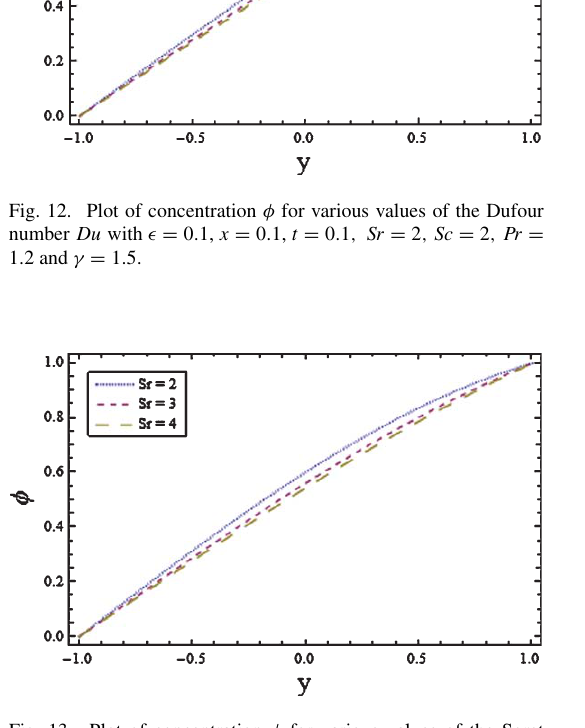
Fig. 13. Plot of concentration φ for various values of the Soret number Sr with (cid:15) = 0 . 1, x = 0 . 1, t = 0 . 1 , Du = 2 , Sc = 2 , Pr = 1 . 2 and γ = 1 . 5